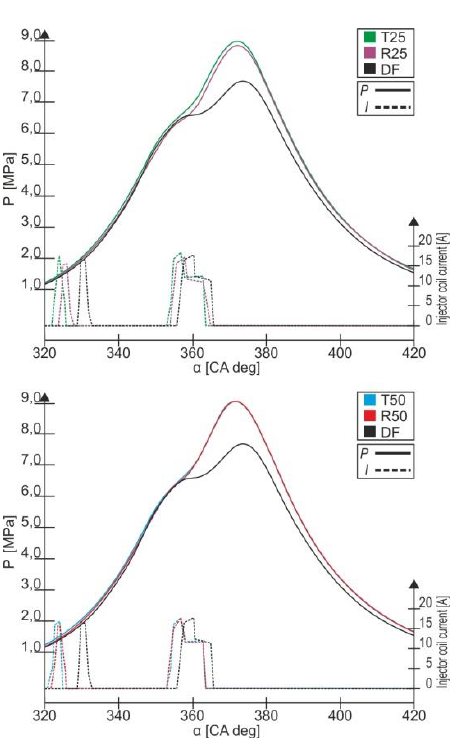
Fig. 5. In-cylinder pressure and injection current versus CA for 200 Nm